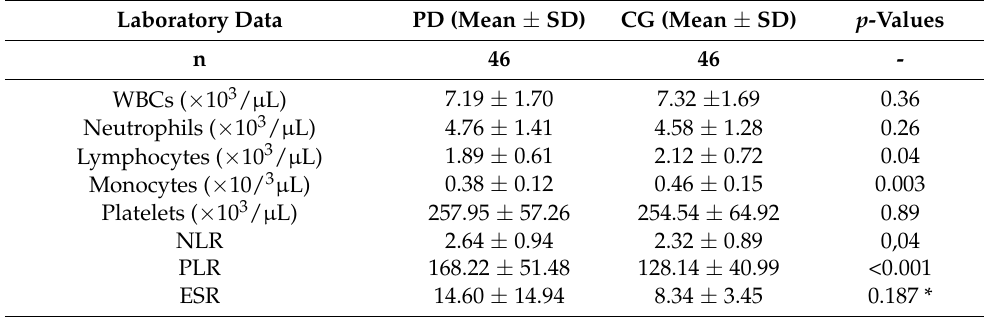
Table 2. Laboratory data in PD patients and CG (statistics are given for t -test except for *, where a Mann–Whitney U test is